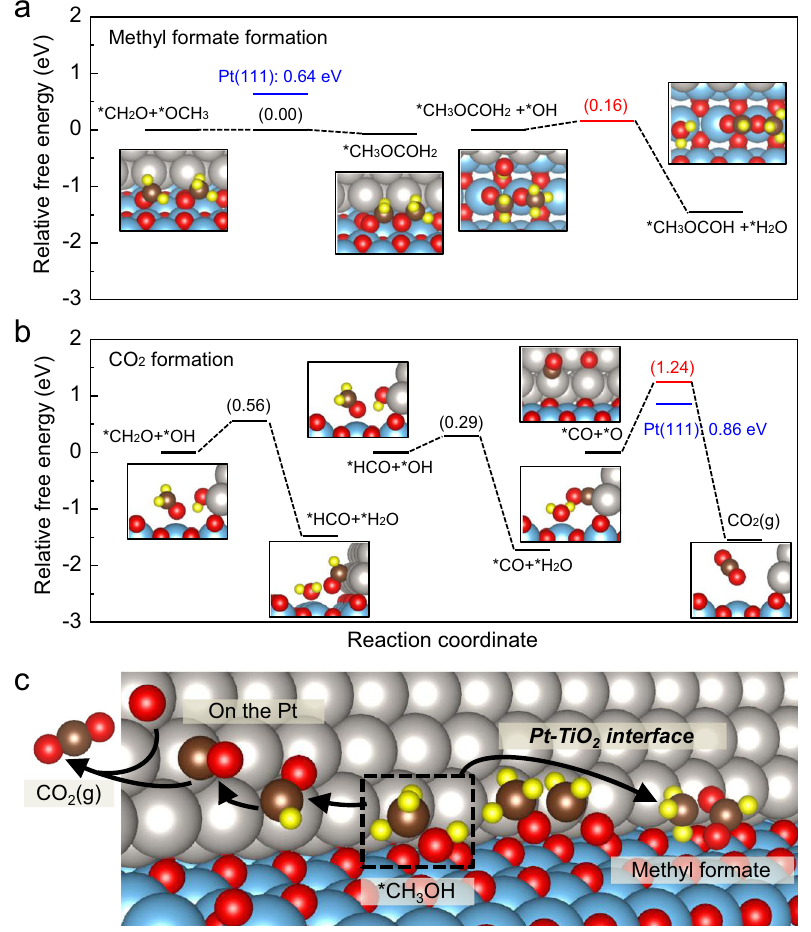
Fig. 4 Calculated activation barrier for Pt nanorod on TiO 2 (110) compared with Pt(111). Optimized free-energy pro fi les for a methyl formate and b the CO 2 formation path with reaction barriers ( Δ G ‡ ). Barriers with red and blue indicate the RDS of each path for Pt nanorod structure on TiO 2 (110) and Pt (111), respectively. c Schematic drawing showing formation of CO 2 and methyl formate in methanol oxidation on Pt nanorod/TiO 2 (110). Species marked with an asterisk (*) are adsorbed on the surface. The gray, blue, brown, red, and yellow balls indicate Pt, Ti, C, O, and H,